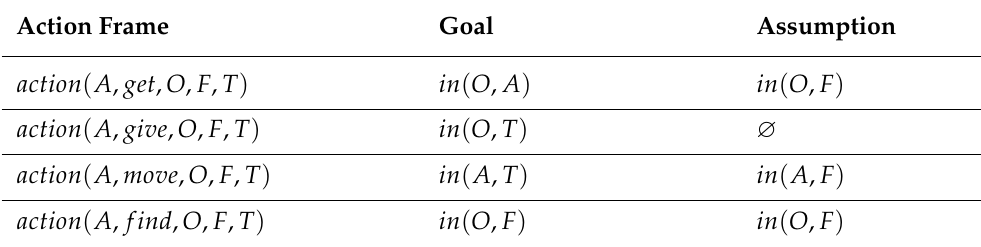
Table 2. Action frame and corresponding